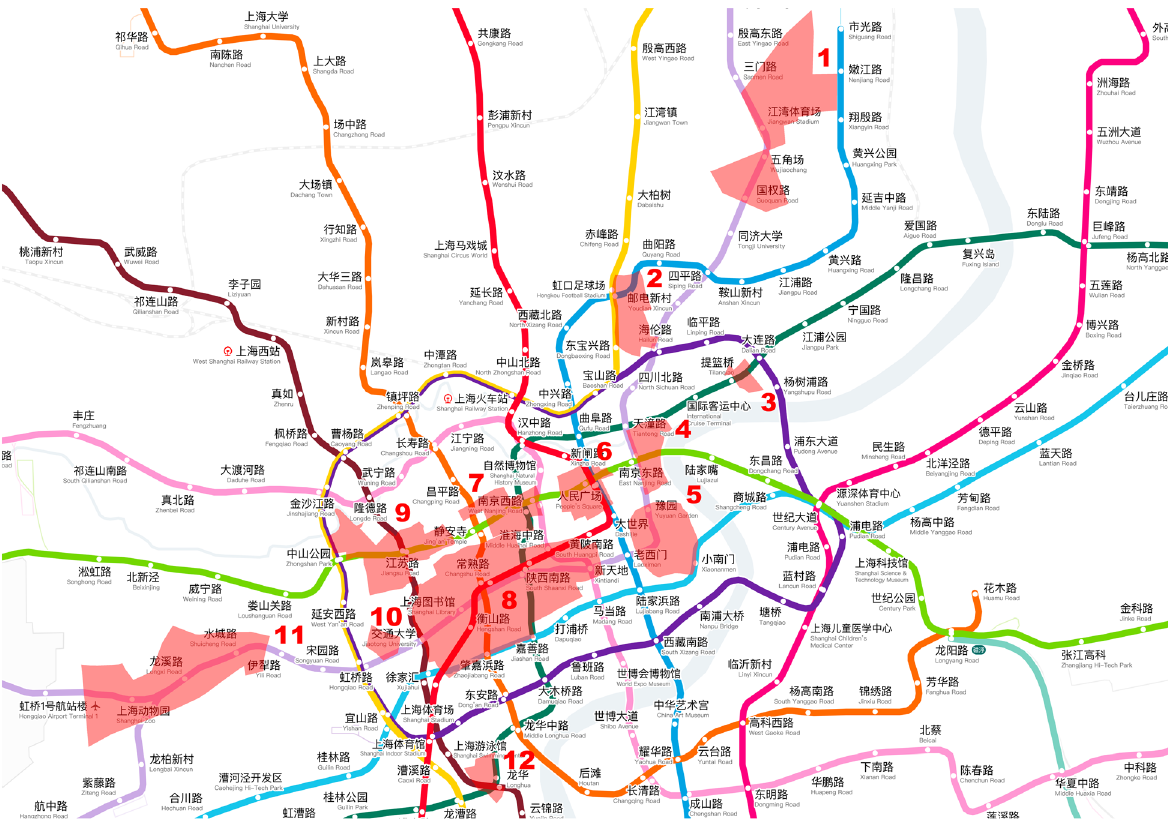
Fig. 1 Superposition of the Shanghai metro network and the location of the 12 cultural and historical listed areas of Shanghai. Legend: (1) Jiangwan; (2) Shanyin Road; (3) Tilanqiao; (4) Waitan; (5) Laochengxiang; (6) People's Square; (7) West Nanjing Road; (8) Hengshan Road – Fuxing Road (Hengfu); (9) Yuyuan Road; (10) Xinhua Road; (11) Hongqiao Road; (12) Longhua. (Source: the